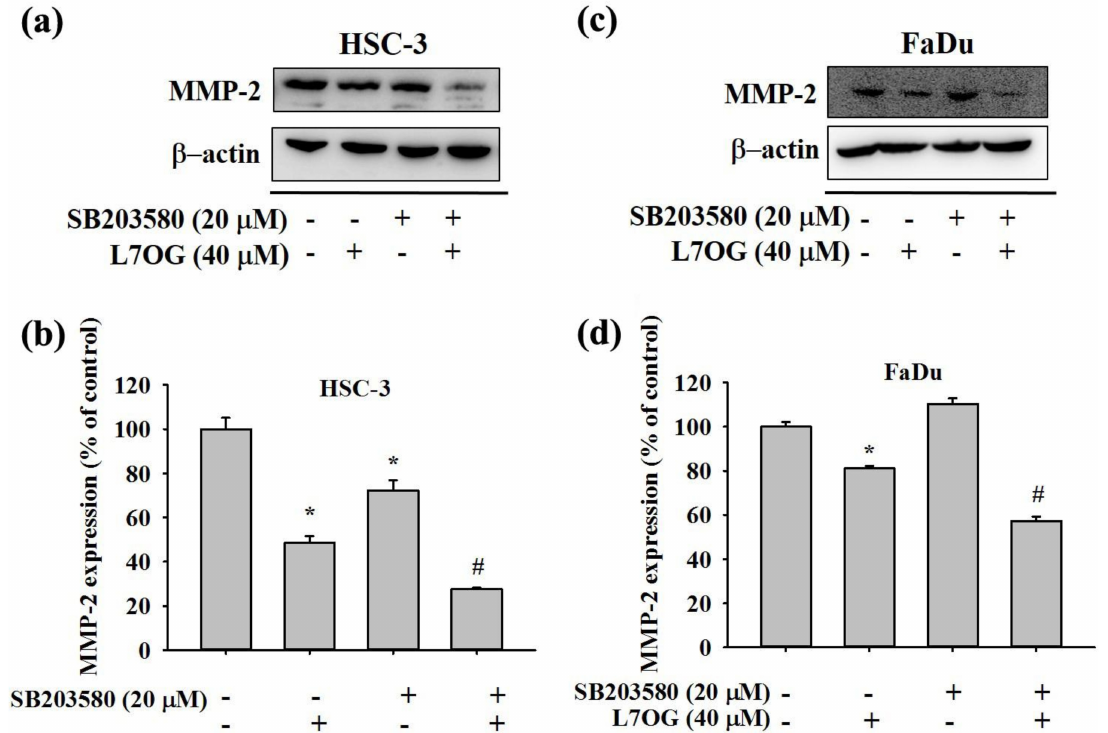
Figure 6. E ff ect of SB203580 and luteolin-7-O-glucoside co-treatment on MMP-2 protein expression in HSC-3 and FaDu cell lines. ( a , b ) HSC-3 and ( c , d ) FaDu cell lines were pre-treated with SB203580 for 1h, followed by treatment with Luteolin-7-O-glucoside for 24 h. Next, the culture medium was subjected to western blot assay to determine the MMP-2 expression. The values are represented as mean ± SD of at least three independent experiments. * p < 0.05, compared to the control group; # p < 0.05, compared to the luteolin-7-O-glucoside treated